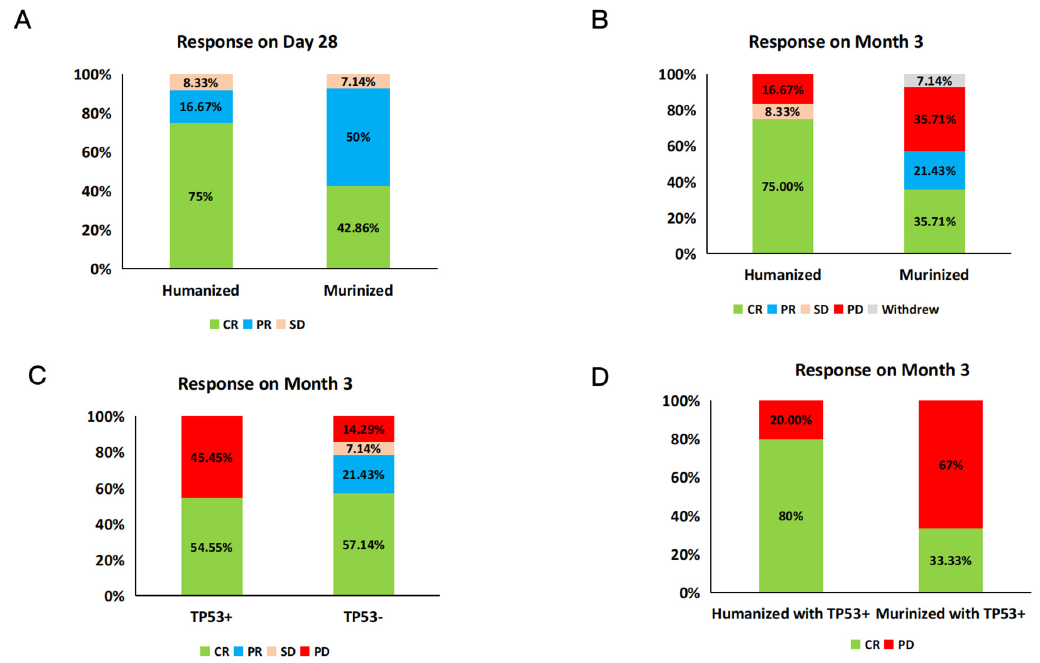
Figure 2. Response comparison between the murinized and humanized groups. Shown are the clinical outcomes of the murinized group and humanized group on day 28 ( A ) and month 3 ( B ). ( A ) On day 28, the humanized group had a higher CR rate than the murinized group (75% vs. 42.9%). ( B ) At month 3, the percentage of patients achieving CR in the murinized group and humanized group were 35.7% and 75.0%, respectively. Pt03 withdrew from the murinized group. ( C ) The various response at month 3 between the patients with TP53+ and TP53 − . The patients with TP53- had a better ORR than the patients with TP53+. ( D ) The response comparison between the patients with TP53+ in the humanized group and the murinized group at month 3. The CR rate of the patients with TP53+ in the humanized group and the murinized group were 80% and 33.33%, respectively. CR: complete response; PR: partial response; SD: stable disease; PD: progressive disease. ORR: objective response